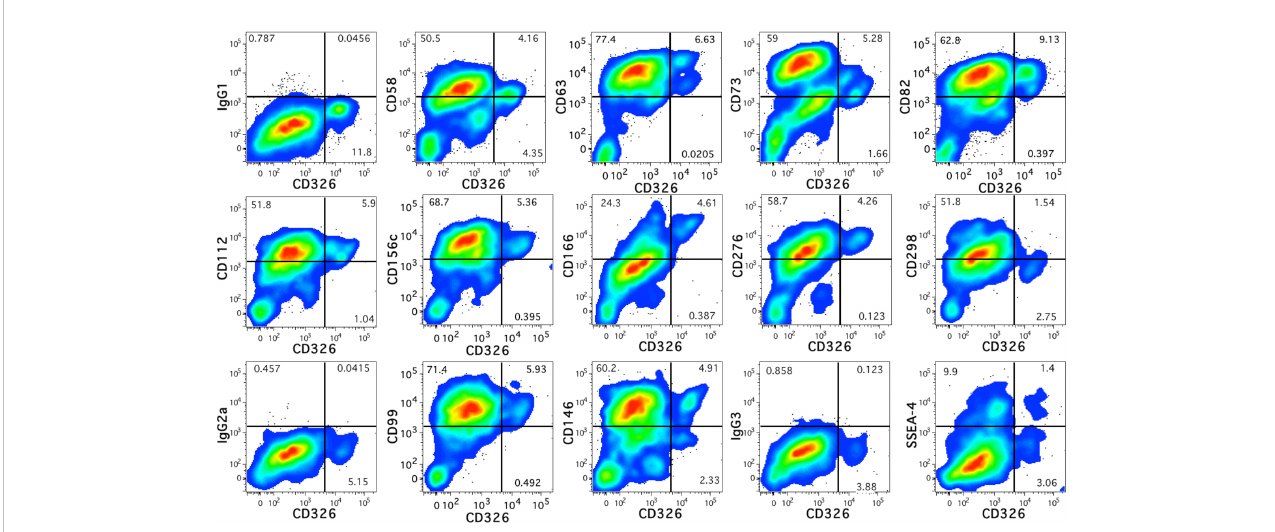
FIGURE 2 Antigen expression on fetal hepatoblasts. Novel antigens expressed by human fetal hepatoblasts identi fi ed by high levels of CD326 staining. The relevant isotype controls are shown preceding plots showing the antigen stains beginning with IgG1 at the